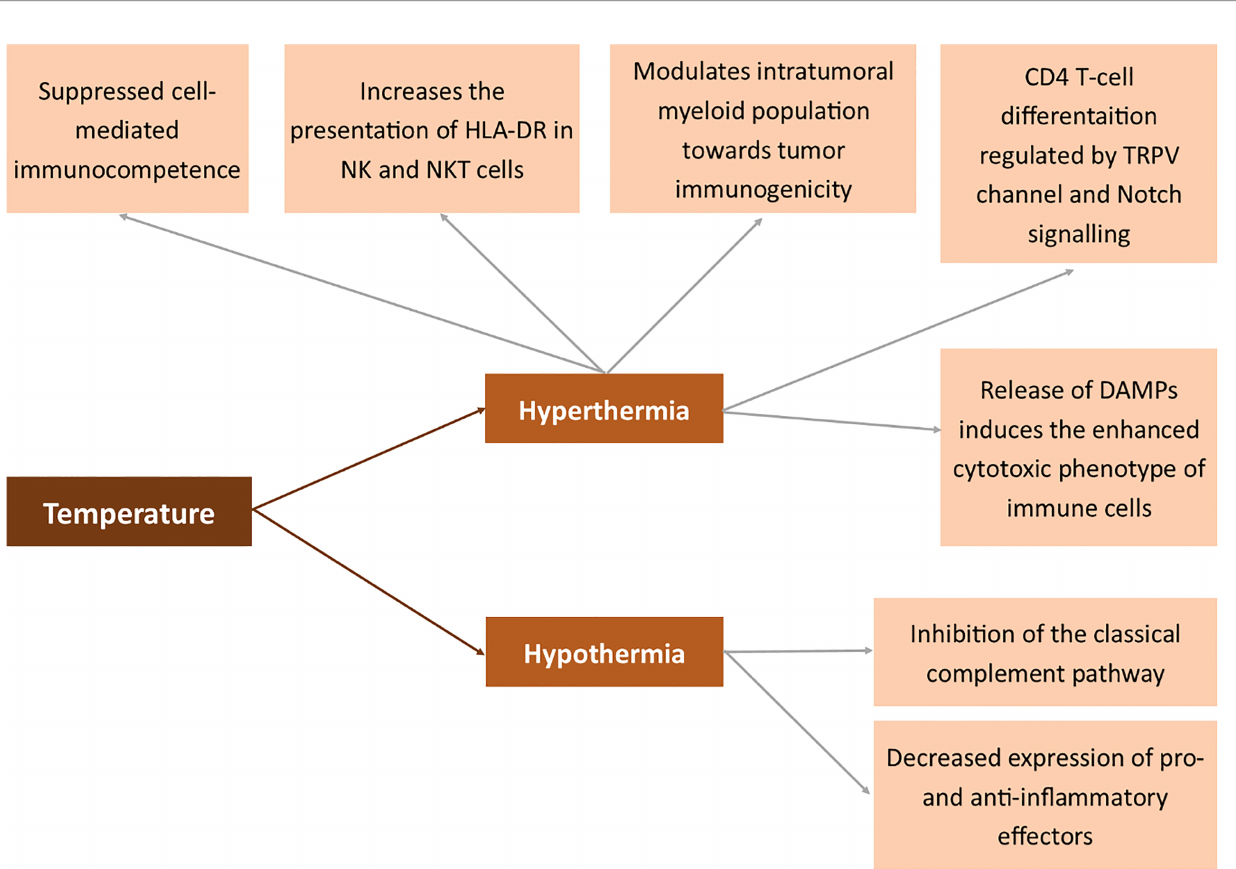
FIGURE 7 | Effects of temperature on the expression of membrane antigens. Human leukocyte antigen DR (HLA-DR), transient receptor potential cation channel (TRPV), Damage-associated molecular pattern